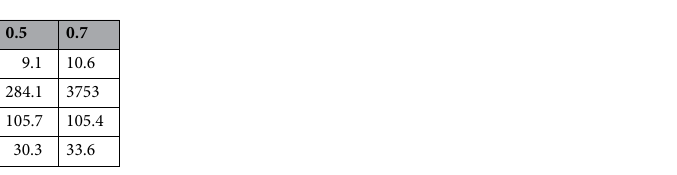
Table 1. The computation time (s) for the different compression